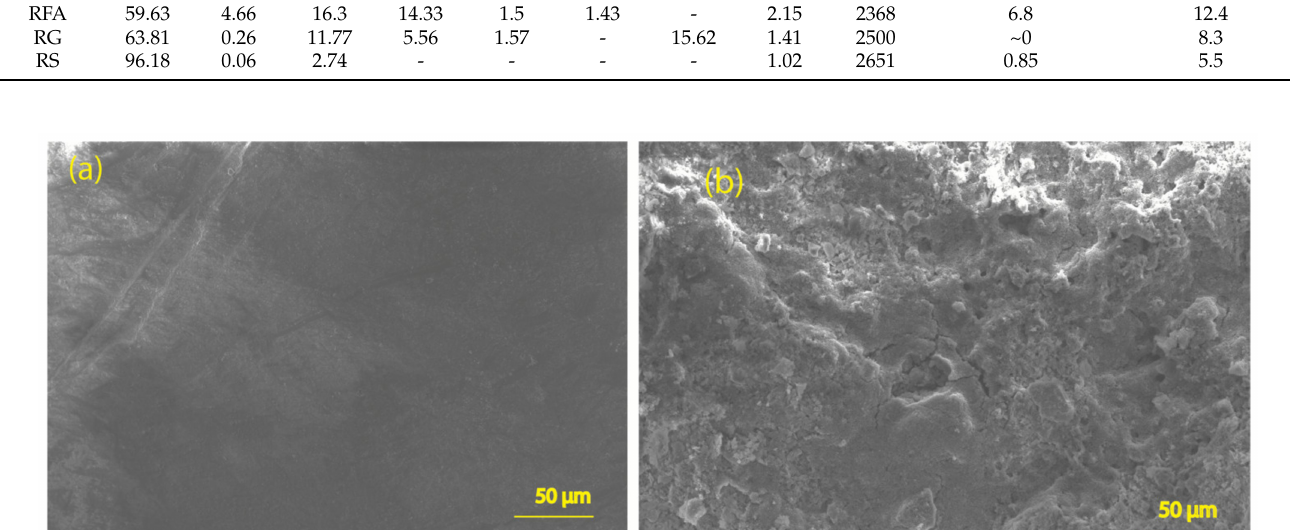
Figure 2. Microstructures of recycled glass (RG) and recycled fine aggregate (RFA): ( a ) micrographs of RG; ( b ) micrographs of